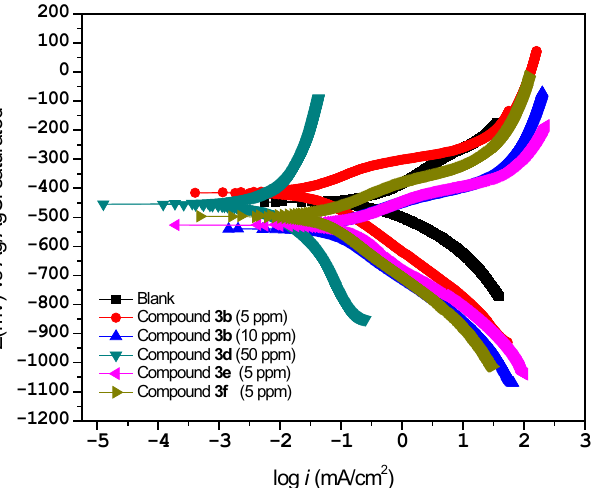
Figure 5. Variation of inhibition efficiency by xanthine triazole for API 5L X70 immersed in HCl 1 M. The Tafel polarization curves were evaluated for the API 5L X70 steel in contact with HCl 1 M in the absence and presence of different xanthine triazoles, in order to obtain comparison parameters between the blank and the inhibitor, are shown in Figure 6.